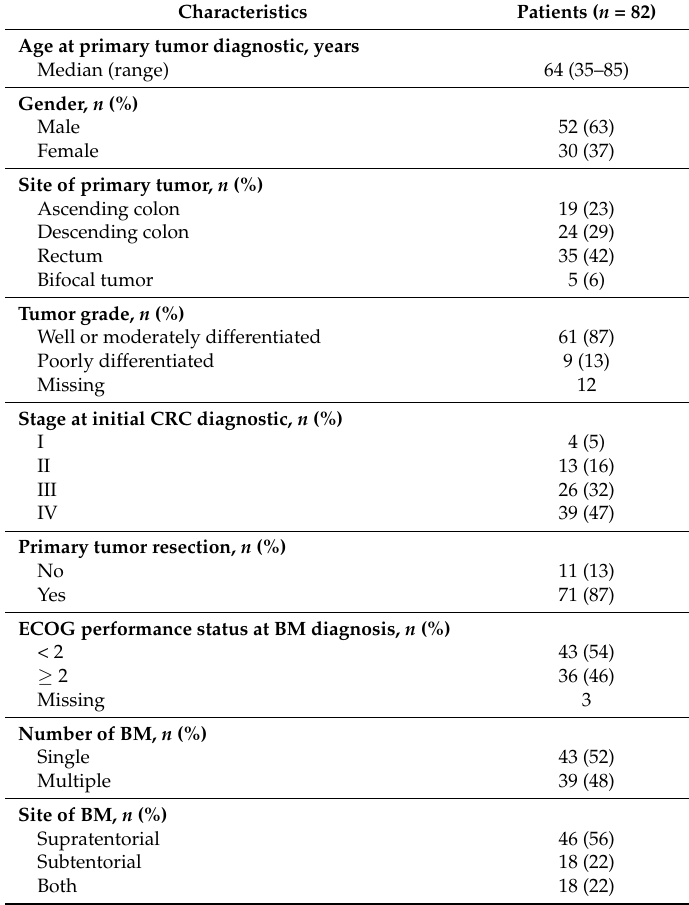
Table 1. Clinical characteristics of patients, primary tumors and brain metastases